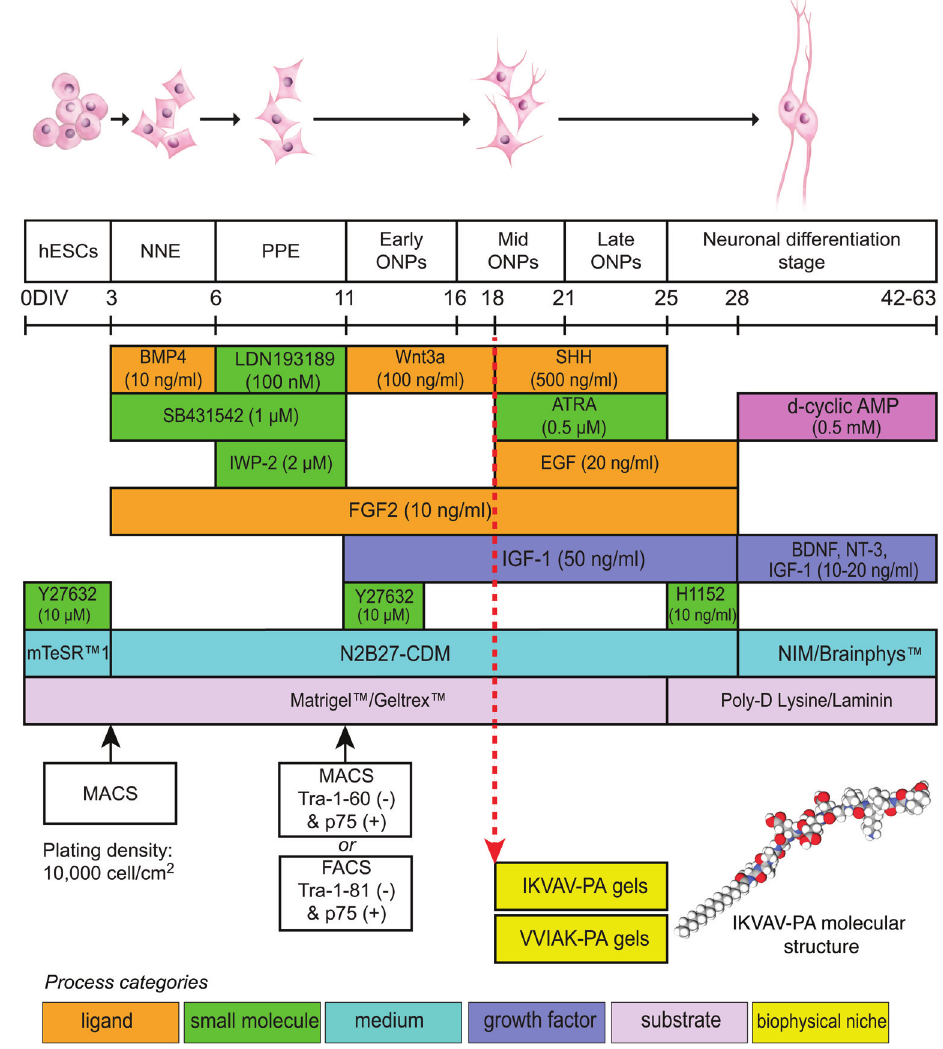
Fig 1. Schematic summaryof the protocol and timeline for deriving the SGN lineage from undifferentiated hESCs. DIV: day in vitro; NNE: nonneuronal ectoderm;PPE: preplacodal ectoderm; ONP: otic neuralprogenitor; BMP4: bone morphogenetic protein 4; SHH: Sonic hedgehog;ATRA: all-trans retinoic acid; EGF: epidermalgrowth factor; BDNF: brain-derived neurotrophic factor; NT-3: neurotrophin 3; IGF-1: insulin-like growth factor 1; FGF2: fibroblast growth factor 2; E8: Essential8 ™ medium; N2B27-CDM: chemically definedmedium containing N2 and B27 supplements; MACS: magnetic-activated cell sorting; FACS: fluorescence-activatedcell sorting; p75: low-affinity neurotrophin receptor(p75 NTR ); IKVAV-PA: IKVAV-containingpeptideamphiphile;VVIAK-PA: VVIAK-containing peptideamphiphile.Protocol adapted and modifiedfrom Matsuoka et al.